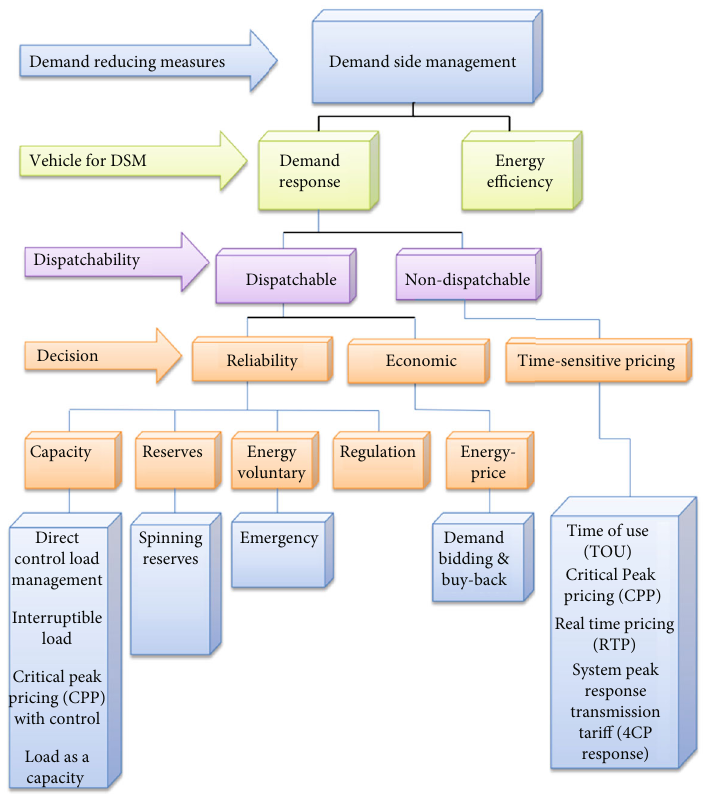
Figure 14: Demand-side management catalog